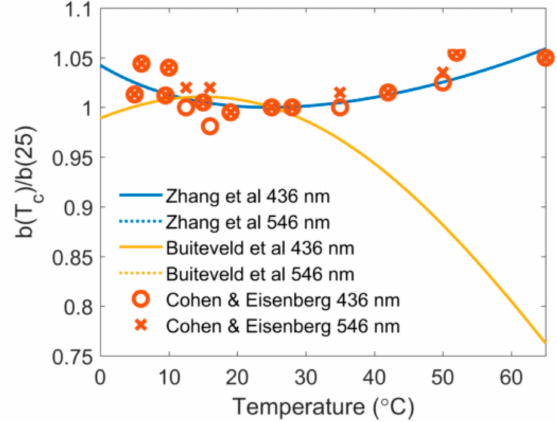
Figure 1. The temperature variations of light scattering by pure water, calculated using the Zhang and Hu [9] model (i.e., Equation (2)) at 436 and 546 nm and normalized by their respective values at 25 ◦ C, are compared with the estimates using the Buiteveld, et al. [7] model and with the measurements by Cohen and Eisenberg [6]. Note that the normalized variations estimated by the Zhang and Hu model overlap with each other at the two